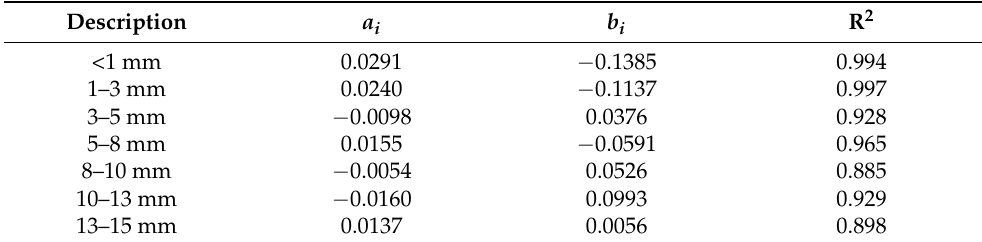
Table 2. Parameter values and correlation coefficients in the Equation (13).